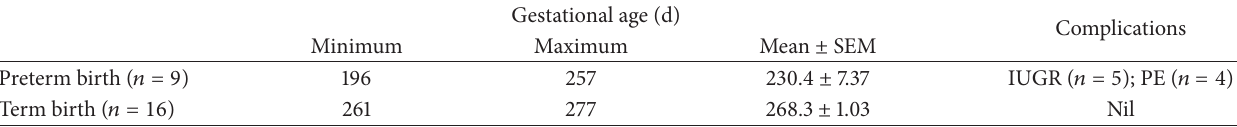
Table 1: Gestational age of both term and preterm